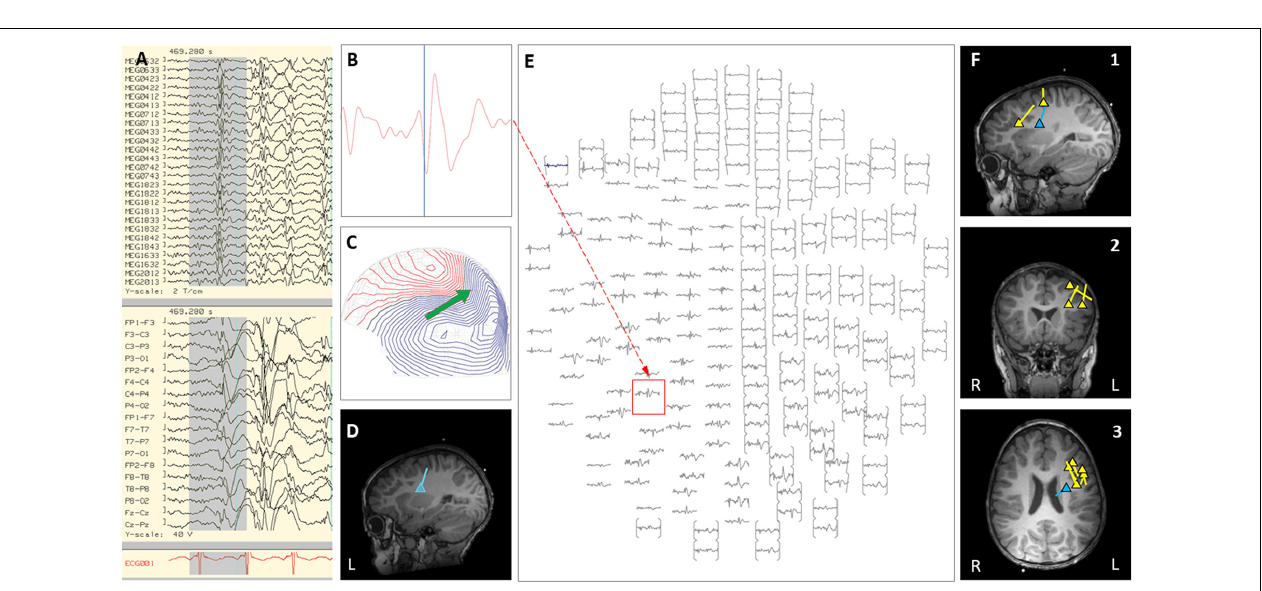
FIGURE 2 | Case 1 (A–E) an example of an individual simultaneous MEG–EEG discharge in the left temporal sensor area. (B) Selected MEG channel and time instance of the magnetic field distribution (C) in sensor space with the projected source estimate (green arrow). The sagittal MRI slices (D) indicates the origin and source orientation of a single discharge at the left temporo-parietal junction. The MEG channel plot (E) of the selected time interval as shown in (A) shows the region of interest and the planar gradiometer channel (red square) with the earliest peak time. The summary pictures (F1–F3) give an impression of the epileptiform activity before surgery (yellow triangles).